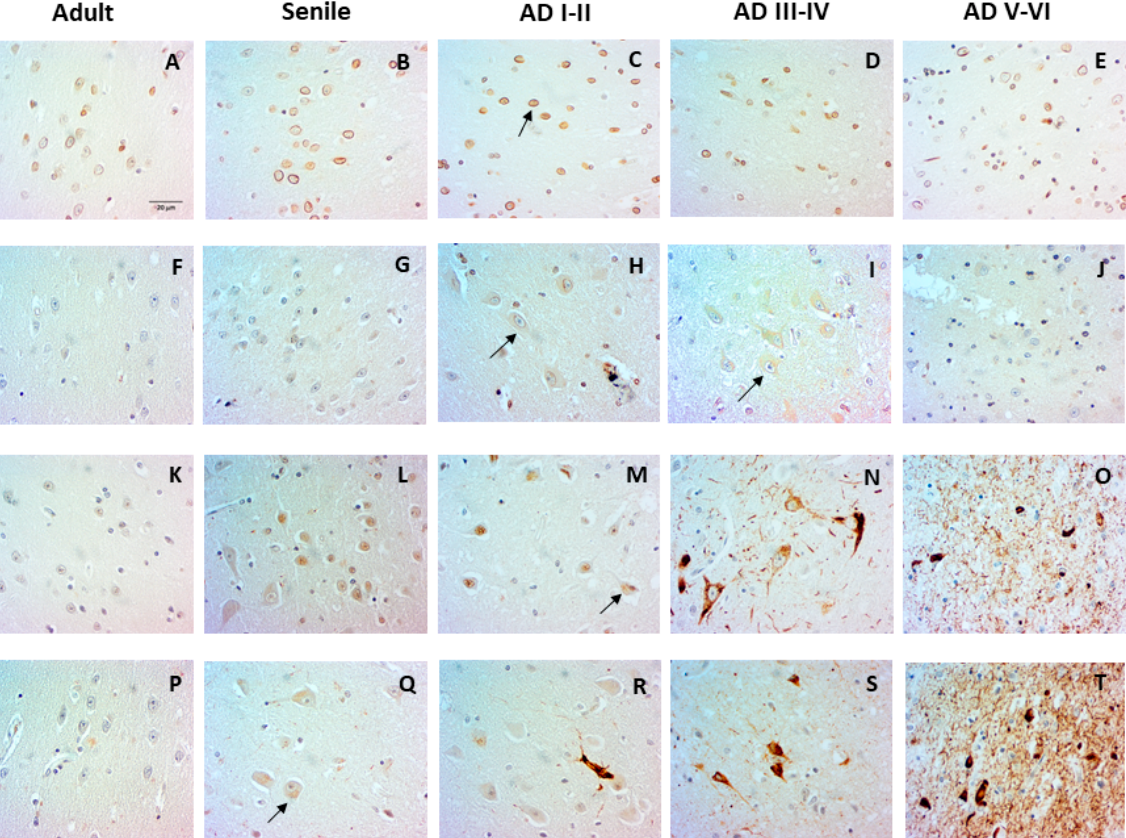
Figure 1. Changes in pyramidal neurons of layer II of the entorhinal cortex. Perinuclear and nucleoplas- mic (arrow) Lamin B2 ( A – E ). Lamin A absence in adult and senile stages ( F , G ) and presence in AD I–IV stages ( H , I ) and absence in AD V–VI stages ( J ). Nuclear Tau, AT100 ( K – M ), AT8 ( Q ) cytoplasmic and extracellular AT100 and AT8 ( N , O , R – T ). Absence of nuclear Tau AT8 ( P ). Scale bar: 20 µ